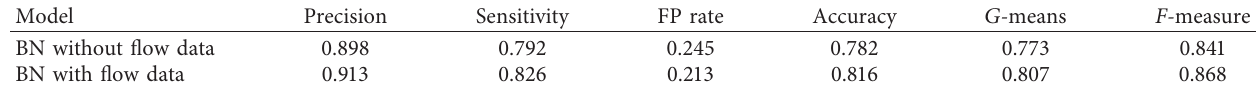
Table 6: Transferability performance of BN